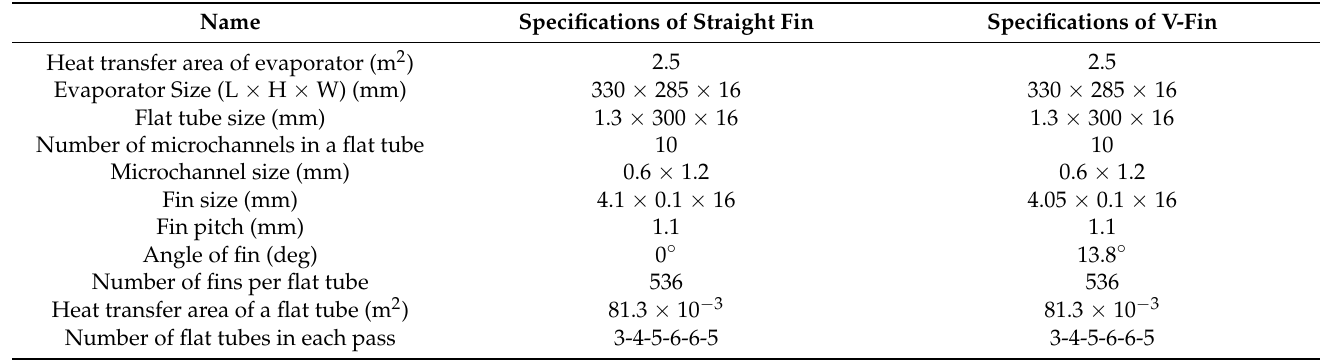
Table 1. Detailed geometries of the microchannel evaporator with the straight fins and the